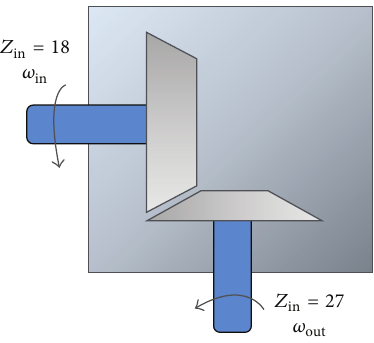
Figure 6: Diagram of the test rig’s gearbox.